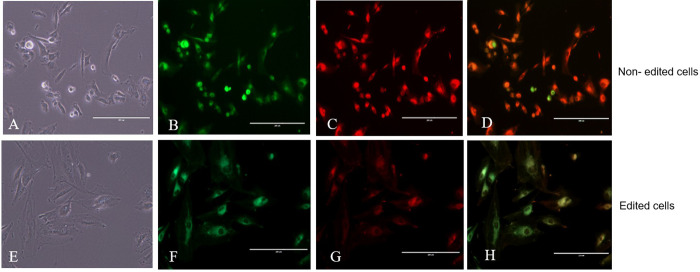
Photomicrograph of epifluorescence with Mitotracker Green and Red markers.Analysis of the mitochondrial membrane potential of edited versus non-edited cells. In A and E control, B-F Mitotracker Green fluorescence, C-G Mitotracker Red fluorescence, and D-H merged.